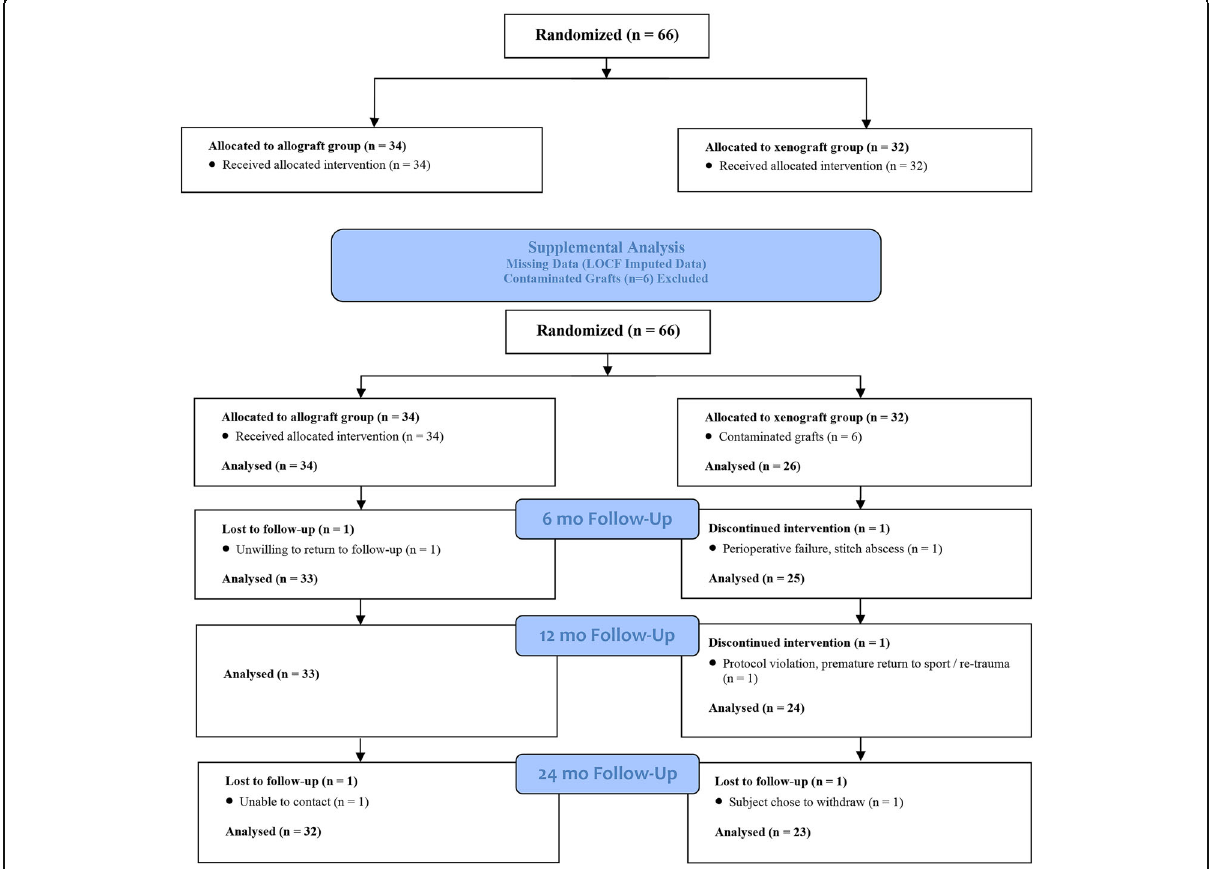
Fig. 1 Flow-chart of inclusion, exclusion and analysis process into this randomized controlled clinical